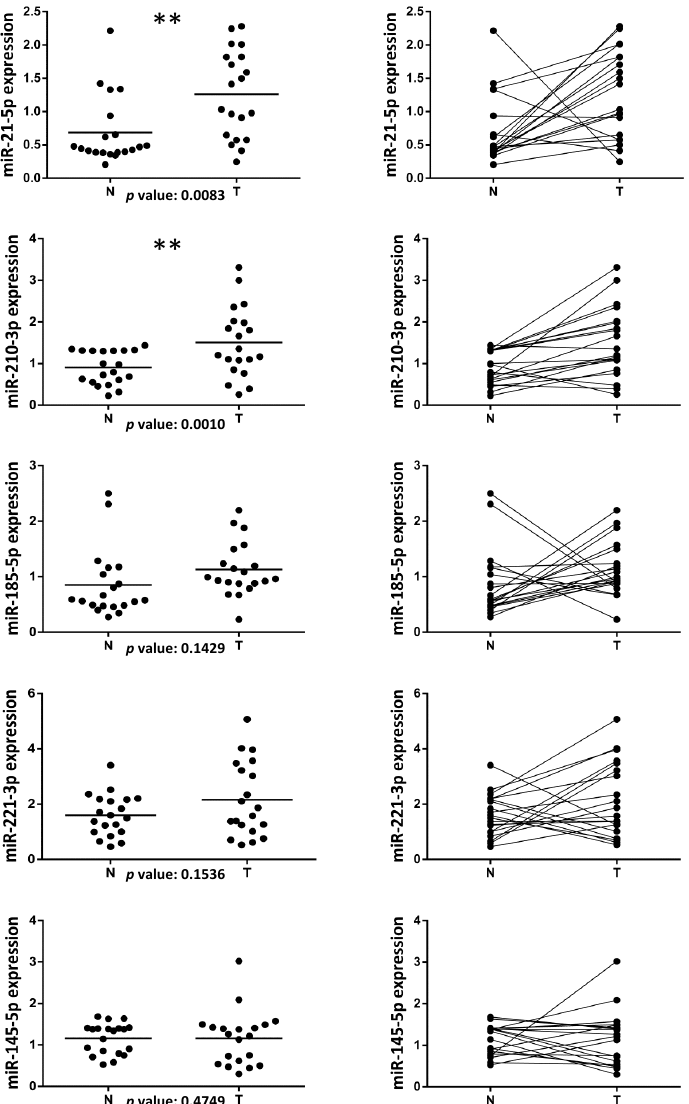
Figure 1. Evaluation of microRNAs levels in clear cell renal cell carcinoma (ccRCC) patients. Dot plots showing the expression of miR-21-5p, miR-210-3p, miR-185-5p and miR-221-3p and miR-145-5p in a retrospective cohort of formalin-fixed paraffin-embedded (FFPE) tissues from 20 ccRCC patients. A total of 20 matched ccRCC tumor (T) and adjacent normal tissue (N) samples were analyzed by RT-qPCR. The expression value of each miRNA was normalized over the average of RNU66, RNU19 and SCARNA17 expression. The p value was calculated by using a non-parametric Wilcoxon test with paired data and miRNAs whose differential expression was statistically significant (** p < 0.01) were indicated. Dot plots with the scatter of the individual data ( left panel) or with connected lines between matched samples ( right panel) are shown. Horizontal lines represent the median expression.